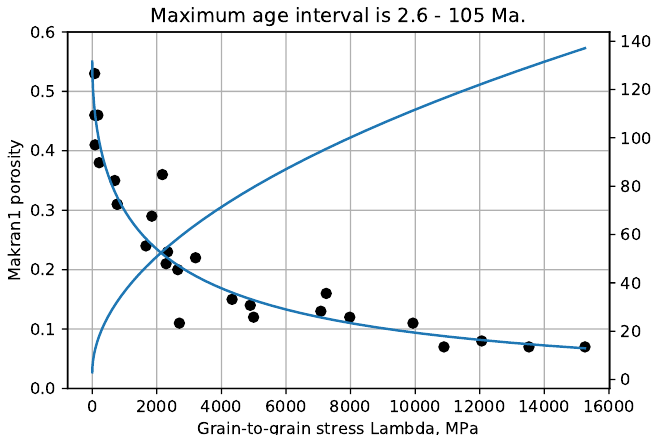
Figure 7. Akita porosity trend. Maximum age interval is 2.6 - 105 Ma.